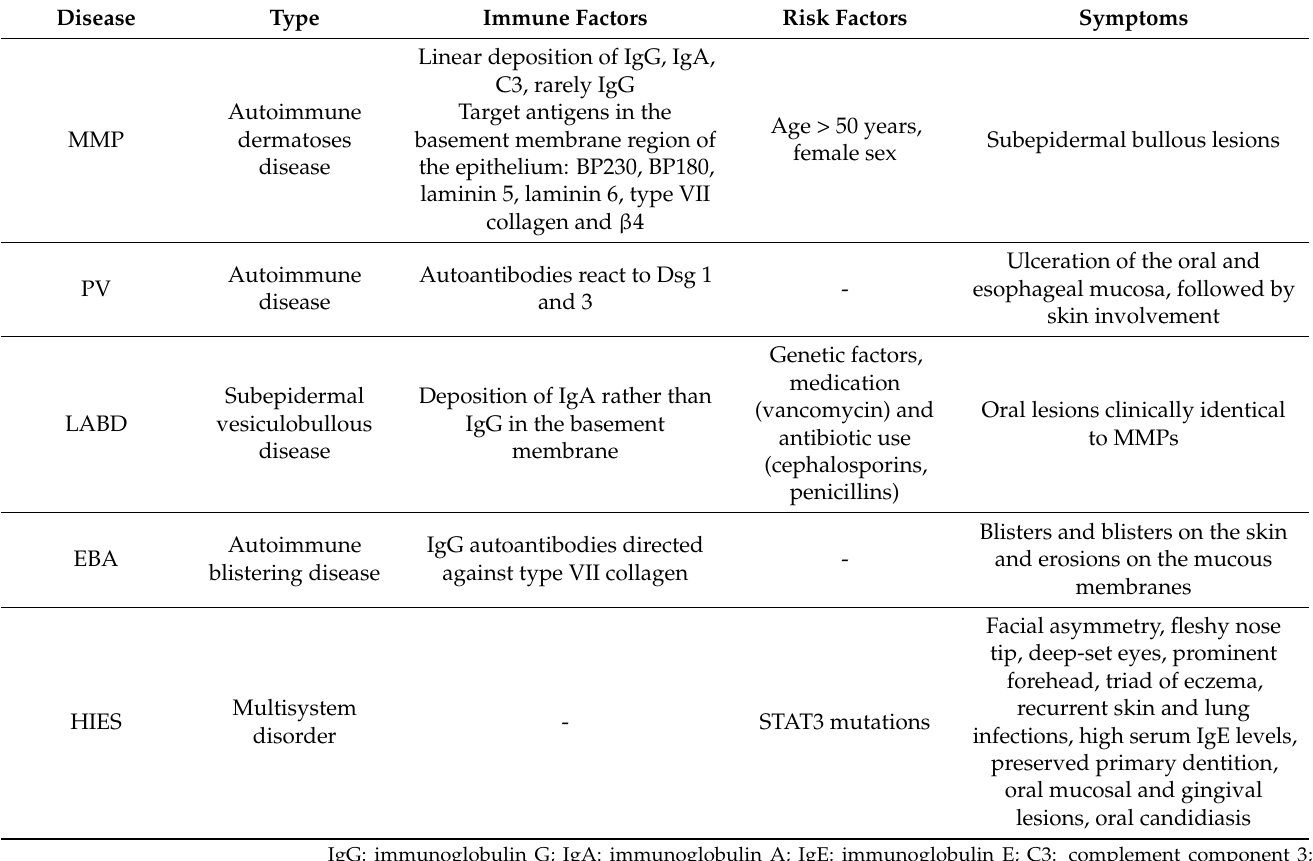
Table 2. Summary of key features of oral manifestations in selected